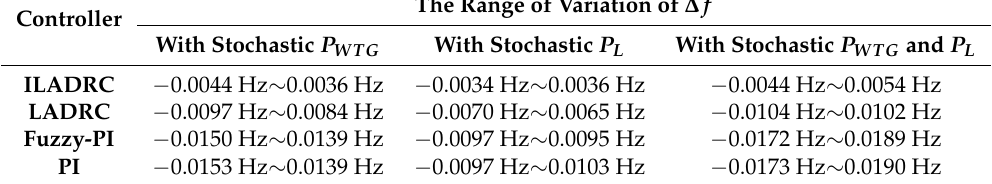
Table 8. Comparison of the range of variation of ∆ f with ILADRC, LADRC, PI and Fuzzy-PI controller under different disturbances.